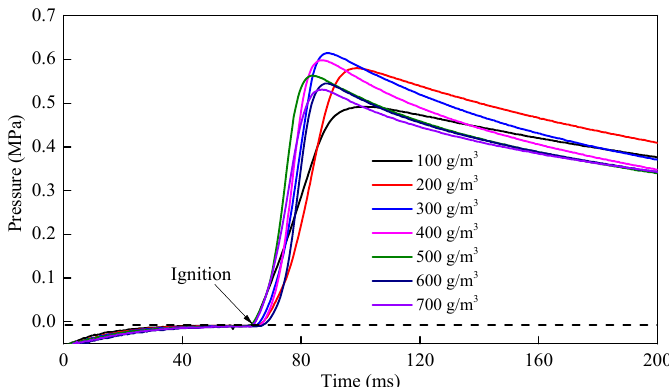
Figure 5. The explosion pressures of the coal dust mixed with a 0% molasses solution at various explosion concentrations.